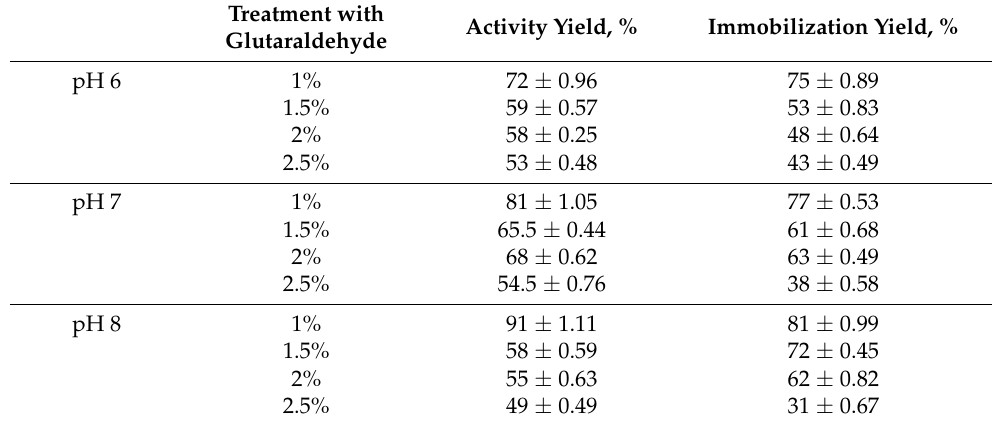
Table 1. Activity yields (AY) and immobilization yields (IY) of lipase loaded on modified PAN. Treatment with